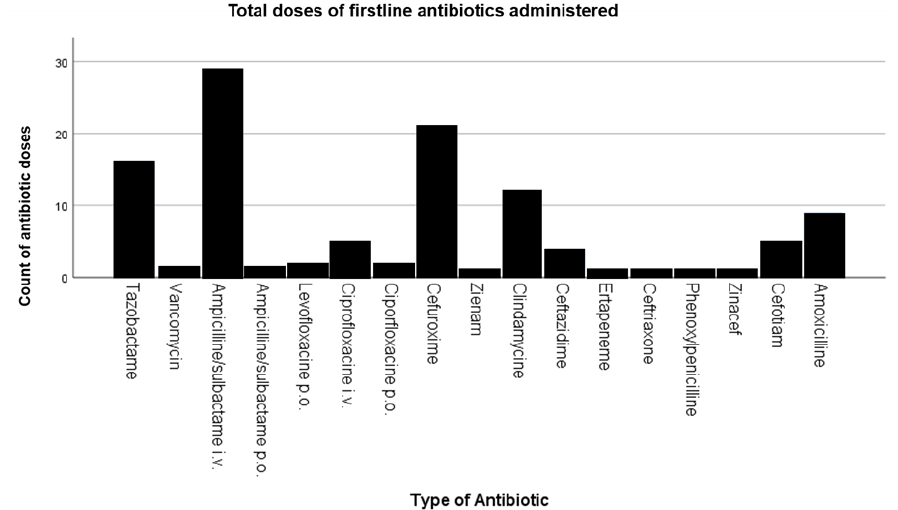
Figure 5. Total number of first-line antibiotic doses administered.